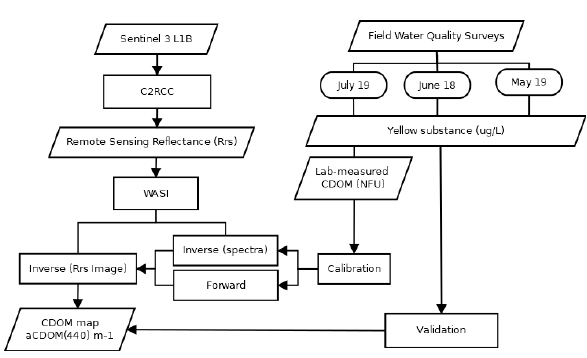
Figure 3. Workflow for calibrating WASI to map Manila Bay CDOM based on field data